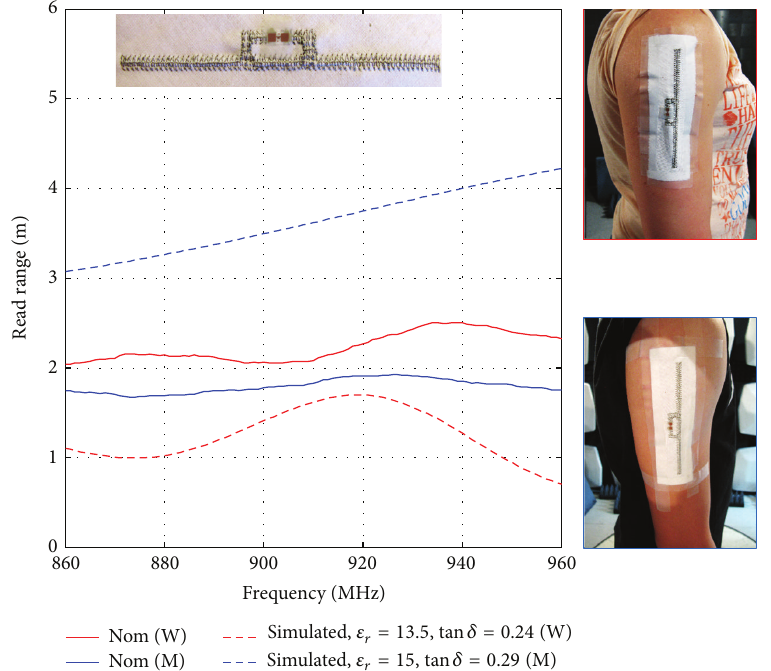
Figure 16: Measured and simulated embroidered tag on human arm and human arm model,